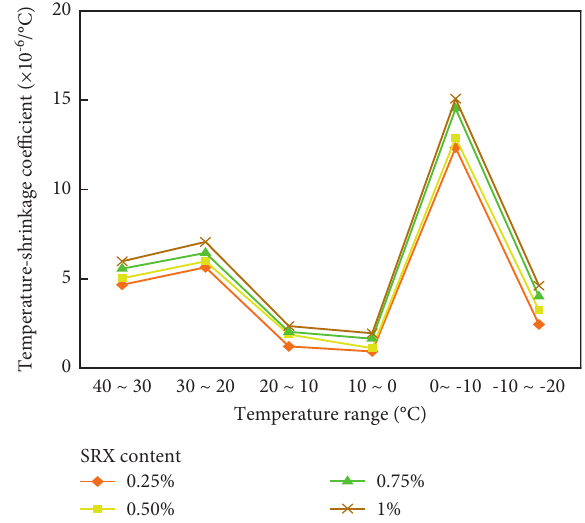
Figure 15: Variation of temperature shrinkage coefficient with different SRX stabilizer